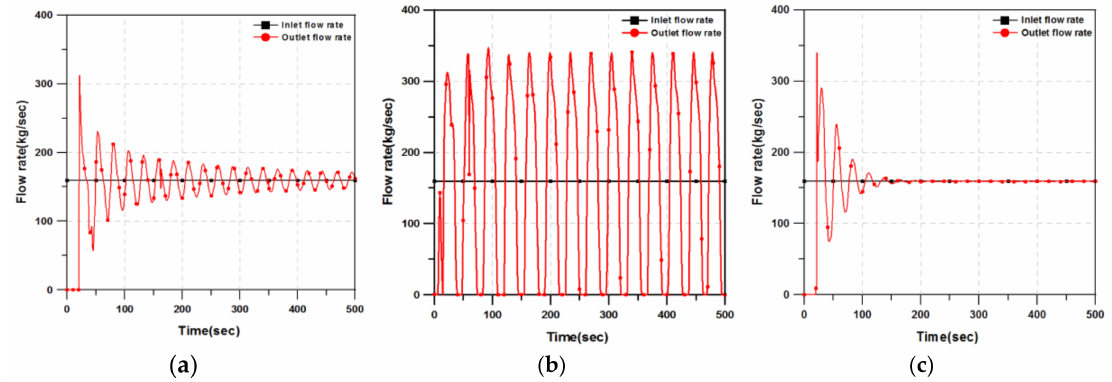
Figure 11. Flow patterns and characteristics diagram in sewer. ( a ) Moderately damped oscillation; ( b ) Oscillation pattern; ( c ) Highly damped oscillation